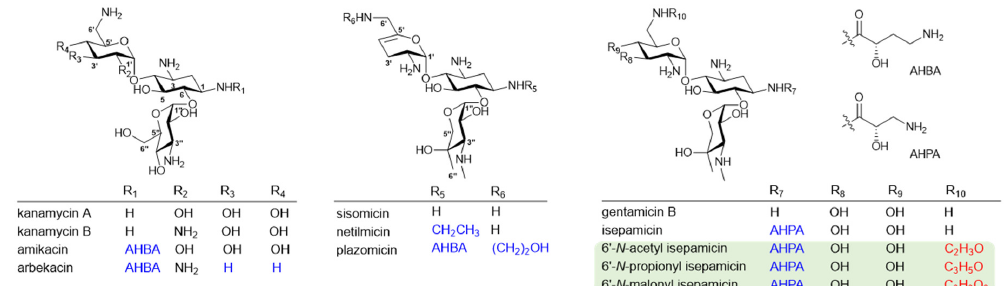
Figure 1. Chemical structures of aminoglycoside (AG) antibiotics currently used in the clinic and 6 ′ - N -acylated isepamicin (ISP) analogs developed in this study. Kanamycin A, kanamycin B, sisomicin, and gentamicin B are natural products, whereas amikacin, arbekacin, netilmicin, plazomicin, and ISP are semi-synthetic AGs, in which the chemically modified features are indicated by blue colors. The greenish inset depicts newly synthesized 6 ′ - N -acylated ISP analogs and red colors represent the functional group formed by the AAC(6 ′ )-APH(2 ″ )-catalyzed enzymatic synthesis in this study. The enzymatic synthesis could be an alternative approach for the development of next- generation antibiotics. Butirosin has an ( S )-4-amino-2-hydroxybutyric acid (AHBA) substituent at the C1-amine, which is introduced by the acyltransferase BtrH and its partner BtrG. The unique AHBA moiety improves antibacterial properties and protects the AG from several common resistance mechanisms [4,5]. Hence, the substrate tolerance of BtrH and BtrG was exploited to successfully introduce an AHBA side chain regiospecifically onto the non-native AGs, suggesting the possibility